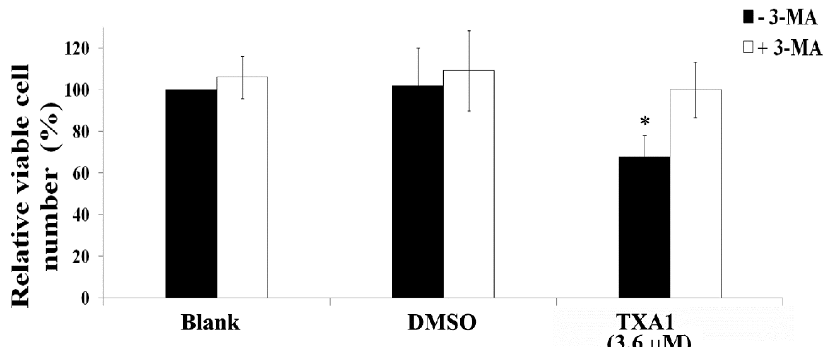
Figure 6. Effect of co-treating A375-C5 cells with TXA1 and 3-MA, on viable cell number. Cells were treated for 48 h with medium (blank), TXA1 (3.6 μ M), or with the corresponding concentration of DMSO, in the absence or presence of 3-MA. Viable cell numbers were analyzed with a trypan blue exclusion assay. Results are presented as the percentage of viable cells in relation to blank cells and are the mean ± SE of three independent experiments. * p ≤ 0.05 Blank vs. treatment.